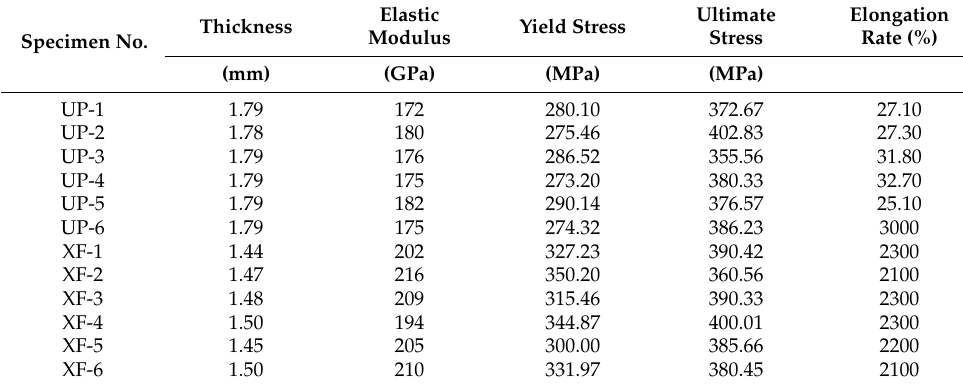
Table 2. Material properties of U-shape connectors and SHS members.